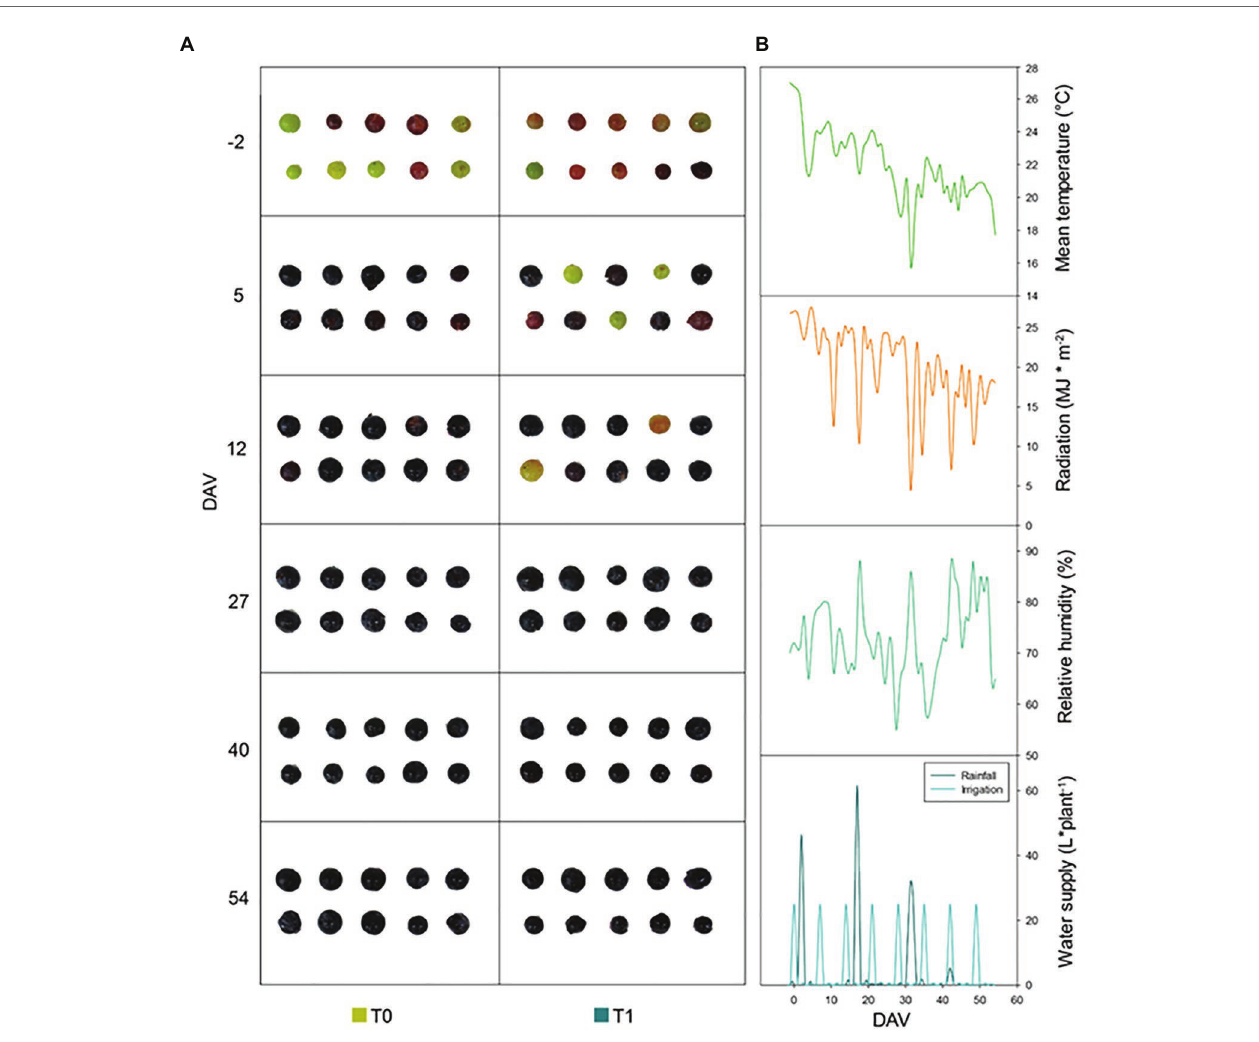
FIGURE 1 | Phenotypic and climatic variations during the study. (A) Representative images of “Merlot” grapes phenotypic evolution throughout ripening for non-irrigated (T0) and irrigated (T1) vineyards. (B) Climatic conditions in the experimental site during the season, including daily mean temperature, solar radiation, relative humidity, and water supply. Note that T0 vines received rainwater only, while T1 vines received rainwater plus 25 L week −1 vine −1 . DAV, days after veraison